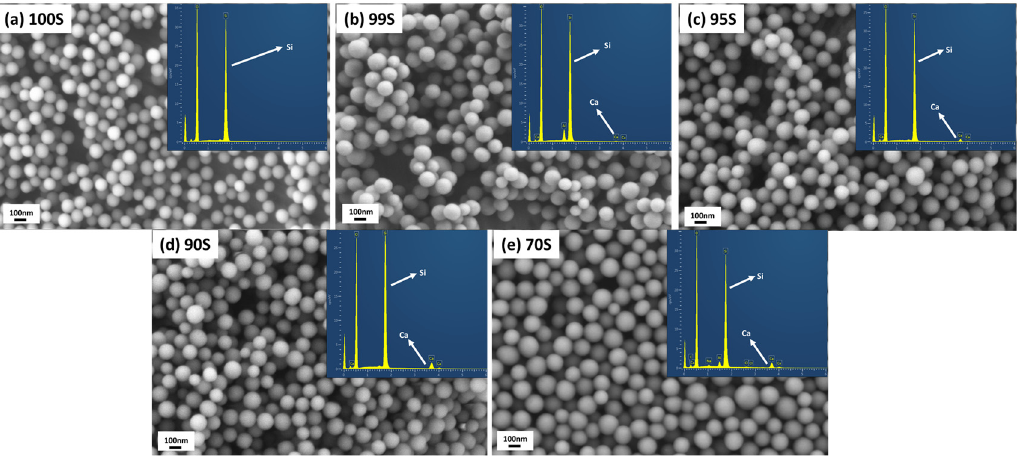
Figure 2. Scanning electron microscopy (SEM) images of ( a ) 100S, ( b ) 99S, ( c ) 95S, ( d ) 90S and ( e ) 70S (inserted corresponding Energy-dispersive X-ray spectroscopy (EDS) spectra).